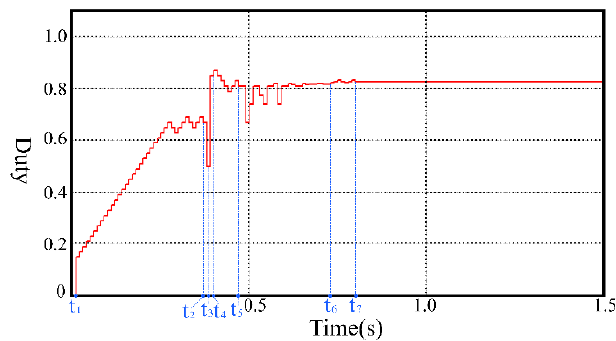
Figure 11. The duty ratio of system with proposed method under PSC.